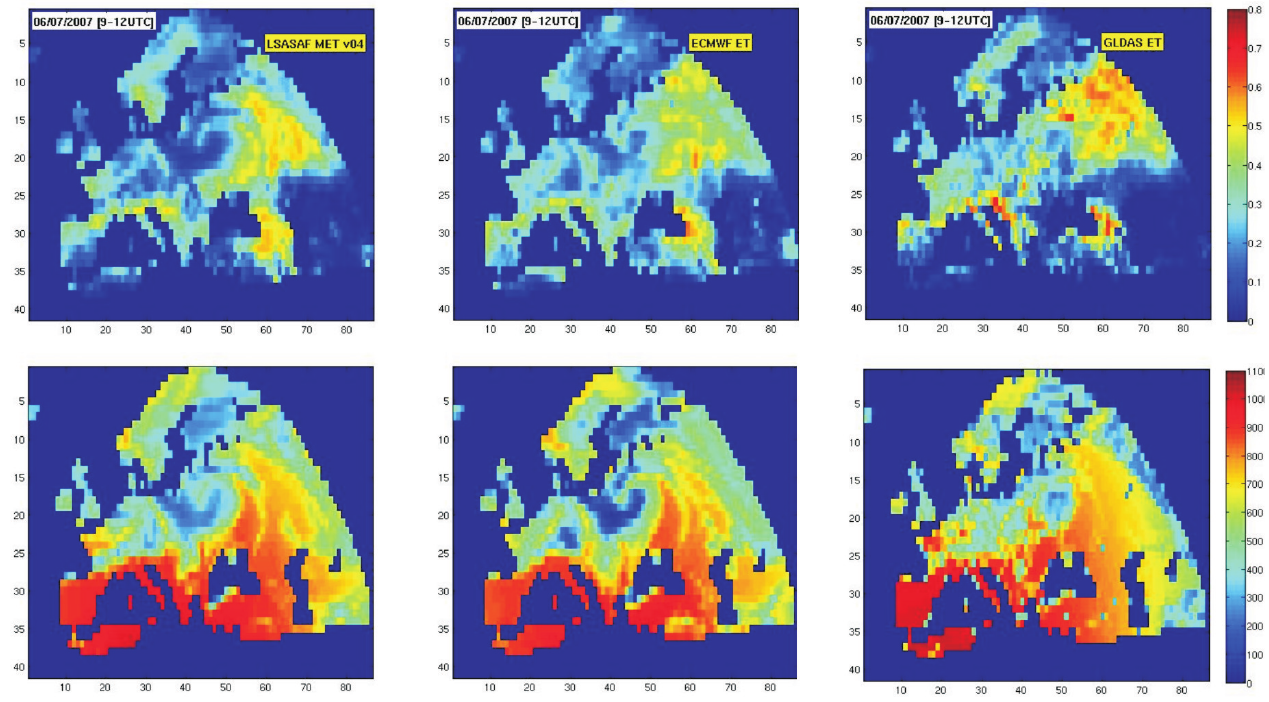
Fig. 4. Comparison of LSA-SAF (left), ECMWF (middle) and GLDAS (right) ET (top) and global radiation (bottom), 3-hourly averages (09:00 to 12:00 UTC, excepted GLDAS global radiation: instantaneous 12:00 UTC) for the 6 July